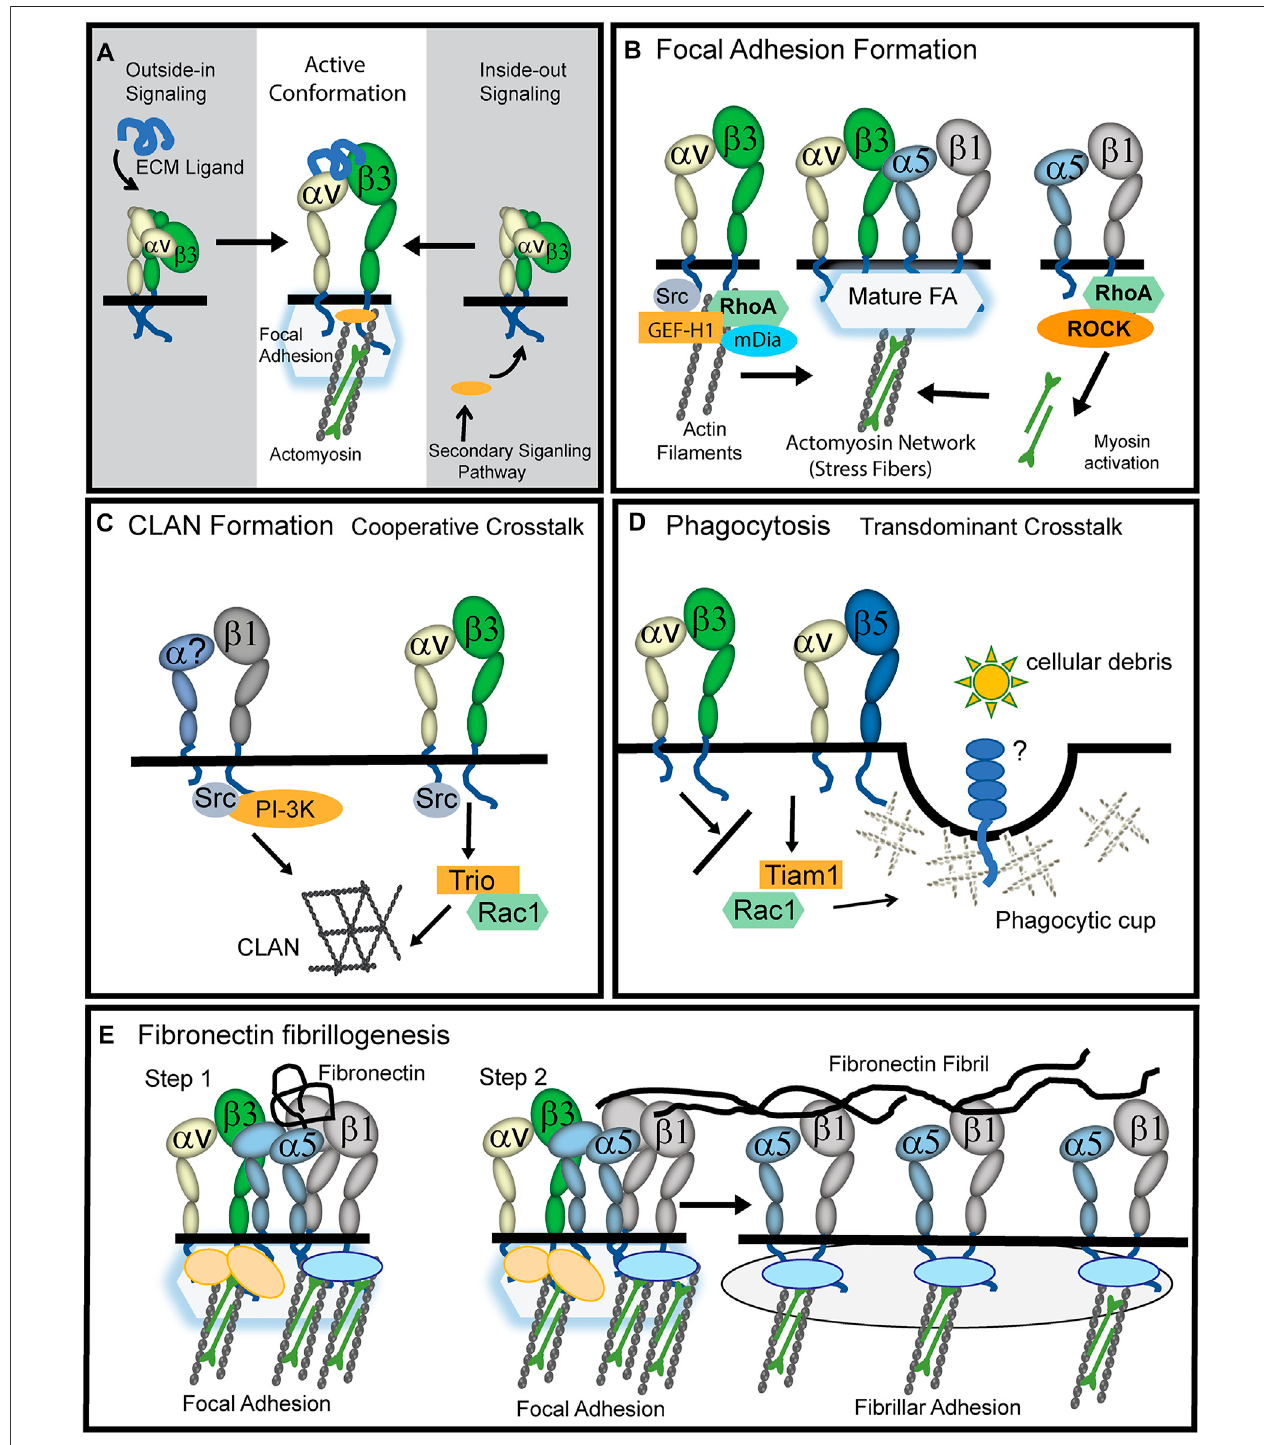
FIGURE1| Roleofactivated α v β 3integrininTM cells. (A) Theactiveconformationof α v β 3integrincanbetriggeredbyaprocesscalledoutside-insignalinginwhich an ECM ligand binds to the extracellular domain of the heterodimer and triggers the upright conformation. Alternatively, a process called inside-out signaling can induce the active conformation. This happens when a secondary signaling pathway triggers the binding of cytoplasmic proteins (orange oval) to the cytoplasmic tails of the integrin causing the cytoplasmic tails to separate and the heterodimer to assume an upright conformation. (B) During the early stages of focal adhesion (FA) formation,actin fi lamentsaregeneratedwhenactivated α v β 3integrinsignalingrecruitsGEF-H1,RhoAandtheRhoeffectormDíatonascentFAs.Stress fi bersinFAsare then formed when signaling from α 5 β 1 integrins recruit RhoA and Rho kinase (ROCK) to the FA and myosin is activated and binds to actin fi laments. (C) Cooperative